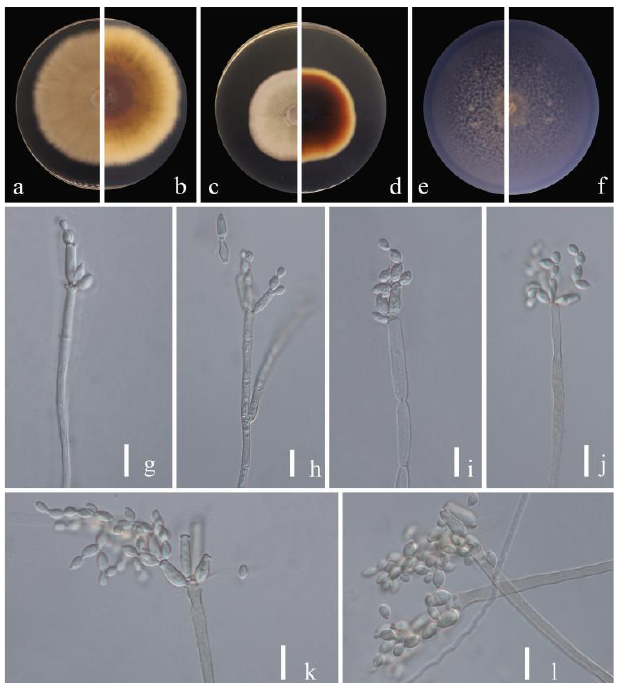
Figure 5. Cladosporium ribus (HGUP 21244, holotype). ( a , b ) Culture on PDA from above and reverse. ( c , d ) Culture on MEA from above and reverse. ( e , f ) Culture on SNA from above and reverse.